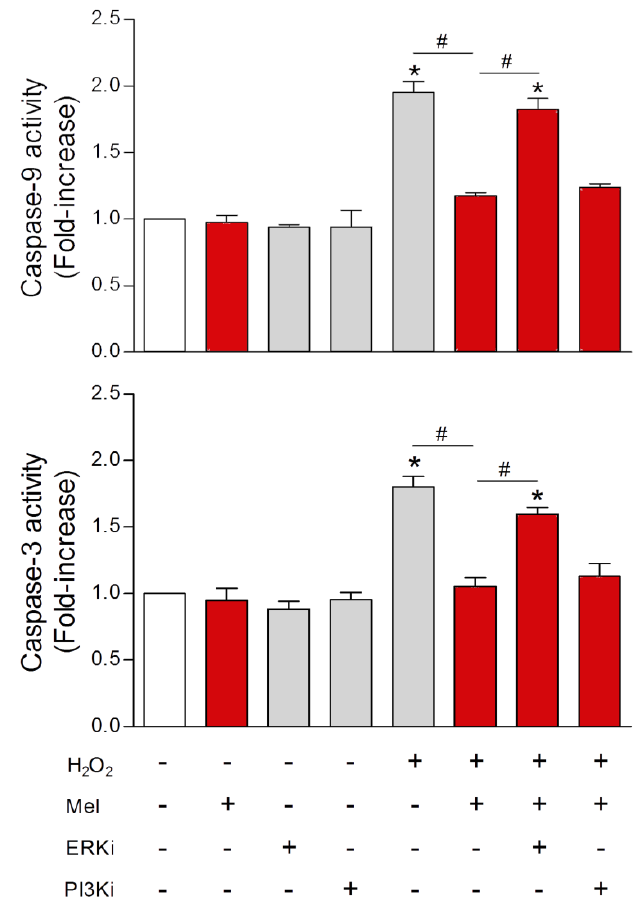
Figure 11. To define the signal transduction pathway relative to melatonin’s actions on human spermatozoa, sperm were exposed to H ERK inhibitor, or to LY294002, a selective pharmacological inhibitor of the P13K/Akt pathway. Clearly, suppressing ERK interfered with the H ( top panel ) and caspase 3 ( bottom panel ) activity indicating that this pathway is related to the ability of melatonin to forestall apoptotic processes in human spermatozoa. * p < 0.05 compared to all other values; # p < 0.05. From Espino et al.